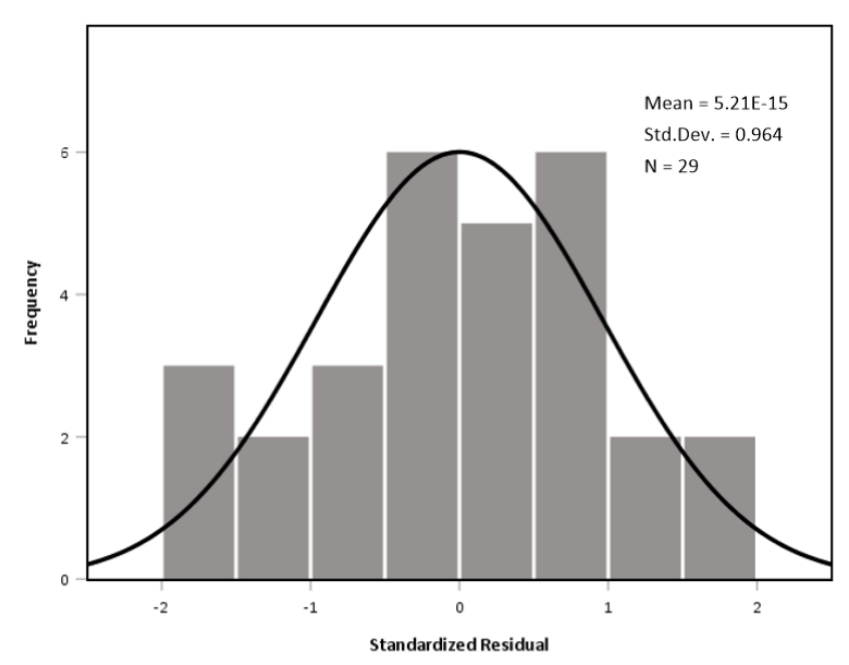
Figure 11. The distribution of the